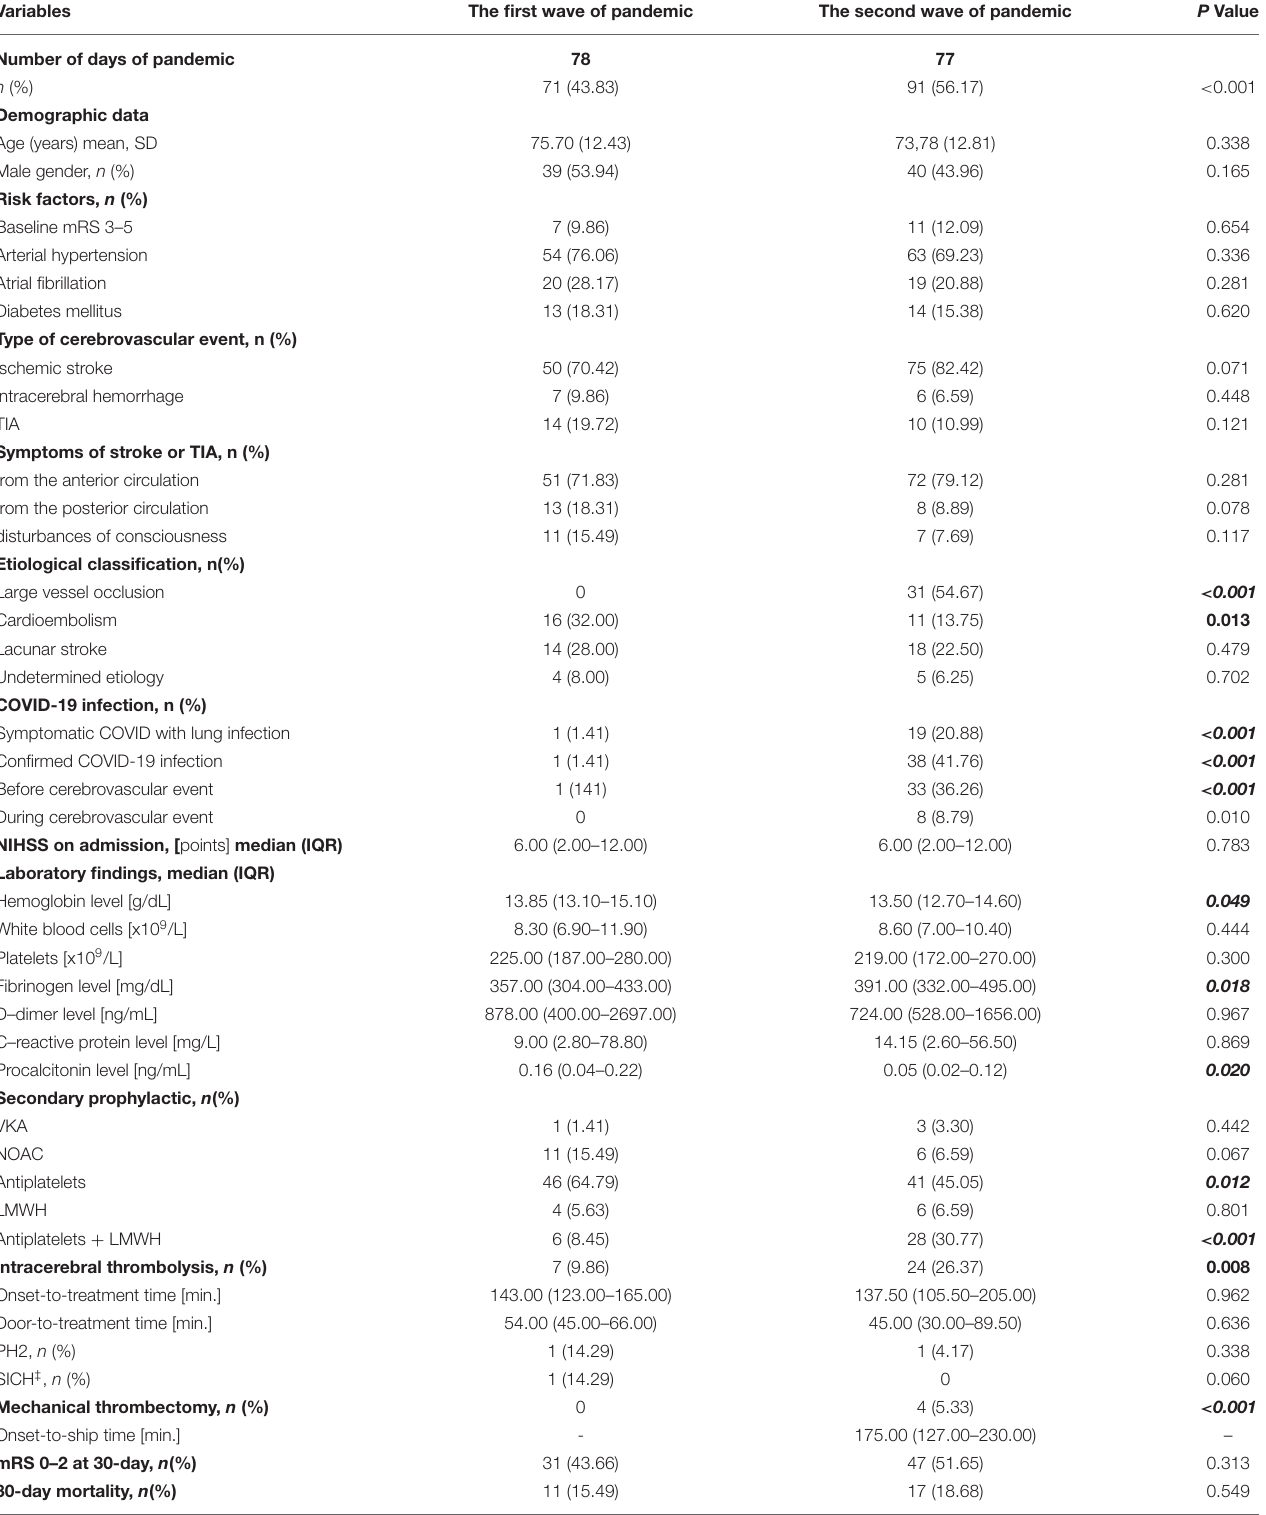
TABLE 1 | The clinical characteristics of the subgroups of patients treated during the first and second wave of the COVID-19 pandemic. Variables The first wave of pandemic The second wave of pandemic P Value Number of days of